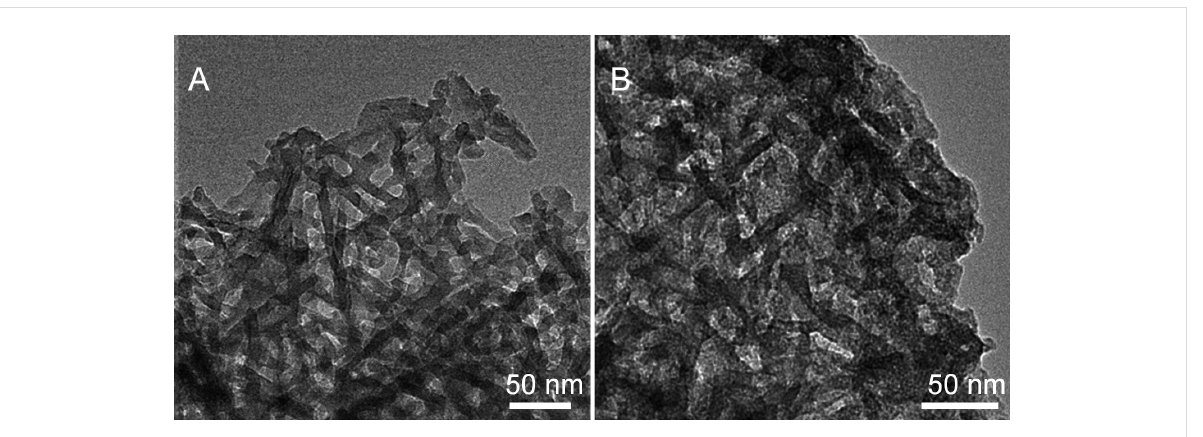
Figure 9: TGA (A) and Raman spectra (B) of silica/carbon composite nanotubes. The samples of a (0.8 wt % carbon), b (7.9 wt % carbon) and c (16.2 wt % carbon) were prepared by calcining LPEI@silica hybrid nanotubes (a), LPEI@silica nanotubes with one layer of adsorbed PSS (b) and two layers of adsorbed PSS (c) under N 2 atmosphere,